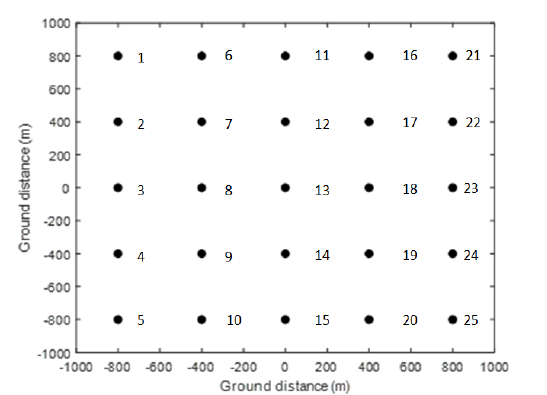
Figure 5. Simulation target scene.